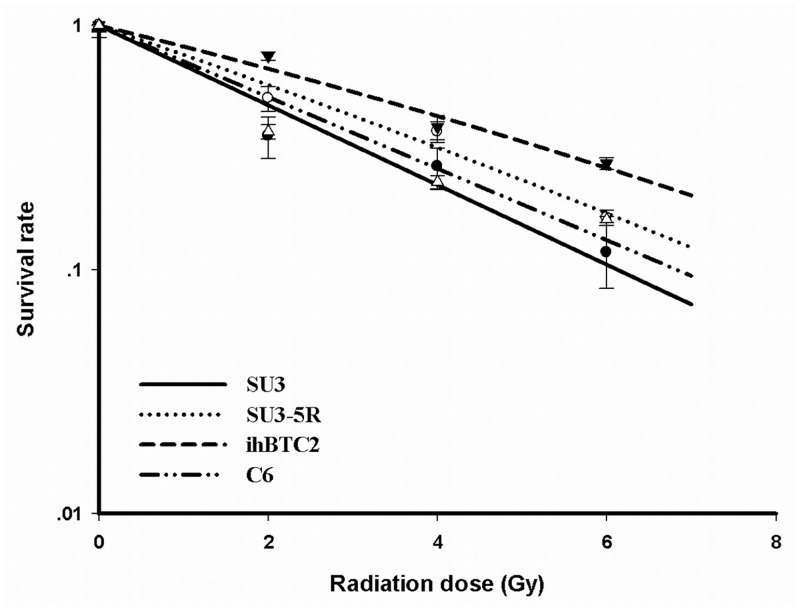
Cell radiation dose-survival curve.The survival rate of the four cell lines decreases as the radiation dose increases in a dose-dependent manner. For radiation resistance, ihBTC2, SU3-5R, C6 and SU3 cells are in descending order.